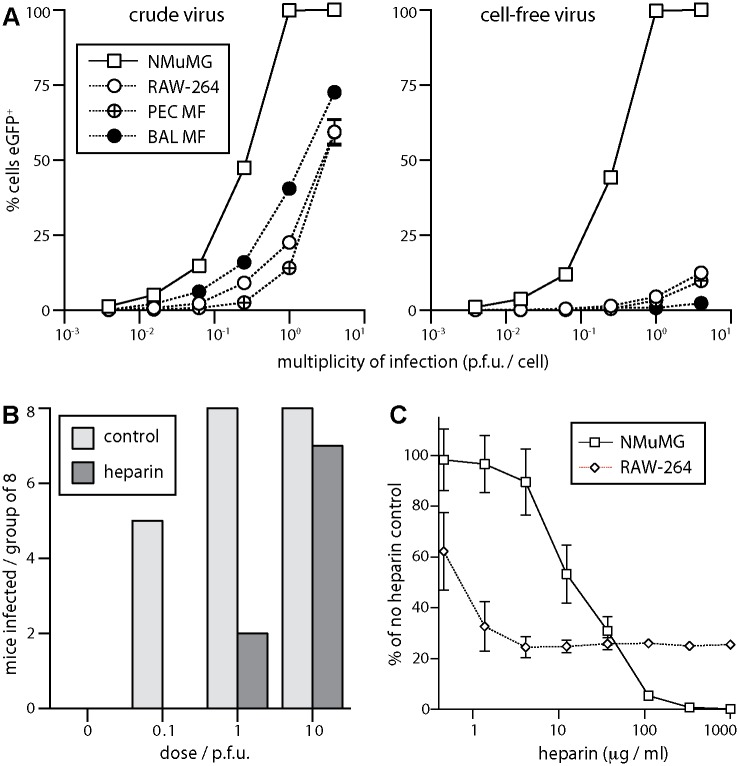
Sensitivity of host entry to inhibition by heparin.
A EGFP+ MuHV-4 stocks harvested from infected cells + supernatants (crude virus), or from supernatants alone followed by 0.45μm filtration (cell-free virus), were used to infect NMuMG epithelial cells, RAW-264 monocytes, macrophages from peritoneal washes (PEC Mϕ), and alveolar macrophages from bronchial washes (BAL Mϕ). The cells were cultured overnight with phosphonoacetic acid (100μg/ml) to allow eGFP expression without further infection spread. EGFP+ cells were then identified by flow cytometry. Each point shows mean ± SD of triplicate cultures—most SDs are smaller than the symbols and so not visible. Crude virus infected significantly more macrophages (p<10-4 by Student’s unpaired 2-tailed t test) and an equivalent number of epithelial cells (p>0.2), indicating a specific barrier to macrophage infection by cell-free virions. B Cell-free eGFP+ MuHV-4 (104 p.f.u./ml) was incubated with heparin (1mg/ml in DMEM, 2h, 23°C) or in DMEM alone (control), then given i.n. to C57BL/6 mice in 30μl at the doses shown (8 mice per group). After 14 days the mice were tested for infection by ELISA of MuHV-4-specific serum IgG. Incubation with heparin reduced significantly infection rates at 0.1 p.f.u. (p<0.03 by Fisher’s exact test) and 1 p.f.u. (p<0.01). C Cell-free eGFP+ MuHV-4 was incubated with different heparin concentrations (2h, 23°C) then added to NMuMG epithelial cells (0.5 p.f.u./cell) or RAW-264 monocytes (5 p.f.u./cell). EGFP expression was determined after overnight culture as in A. Each point shows mean ± SD of triplicate cultures. Virus without heparin gave 65.3% eGFP+ NMuMG cells and 13.1% eGFP+ RAW-264 cells. Heparin inhibited RAW-264 infection significantly better than NMuMG cell infection at <30μg/ml, but significantly worse at >100μg/ml (p<0.001 by Student’s 2-tailed unpaired t test, comparing % inhibition for each cell type).